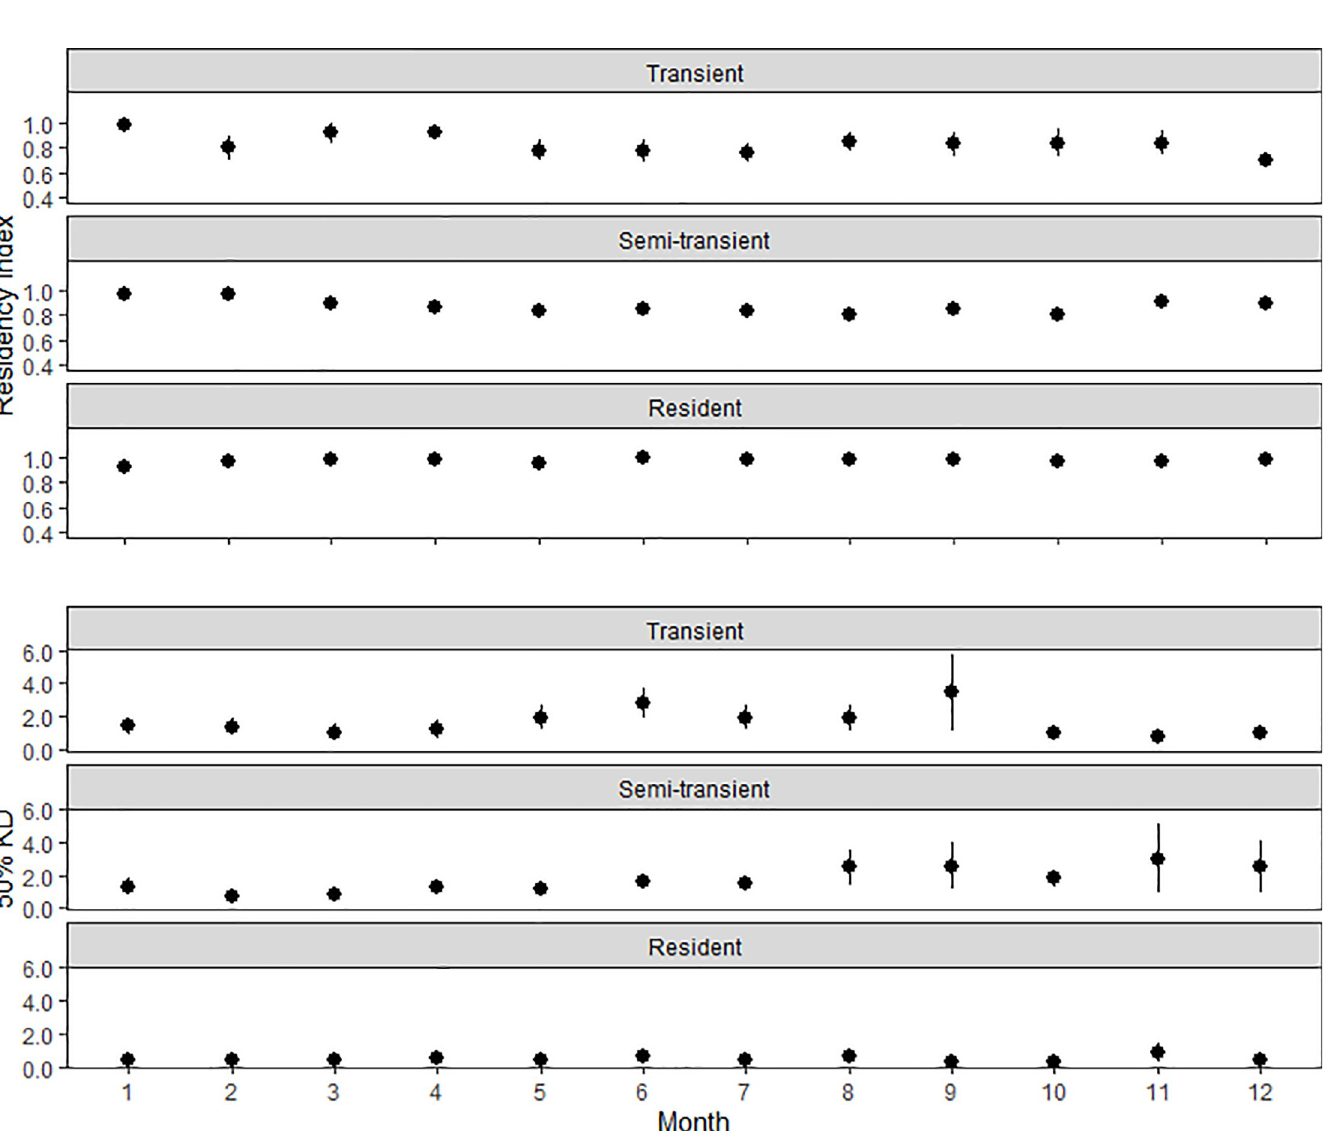
Fig 2. Kernel density and residency index estimates. Monthly 50% and 95% kernel density utilization (KD) and residency index (RI) estimates for all female grey reef sharks Carcharhinus amblyrhynchos monitored by acoustic array at Pohnpei and Ant Atoll from January 2010-October 2013. Error bars represent standard error. The outlined box represents the aggregation